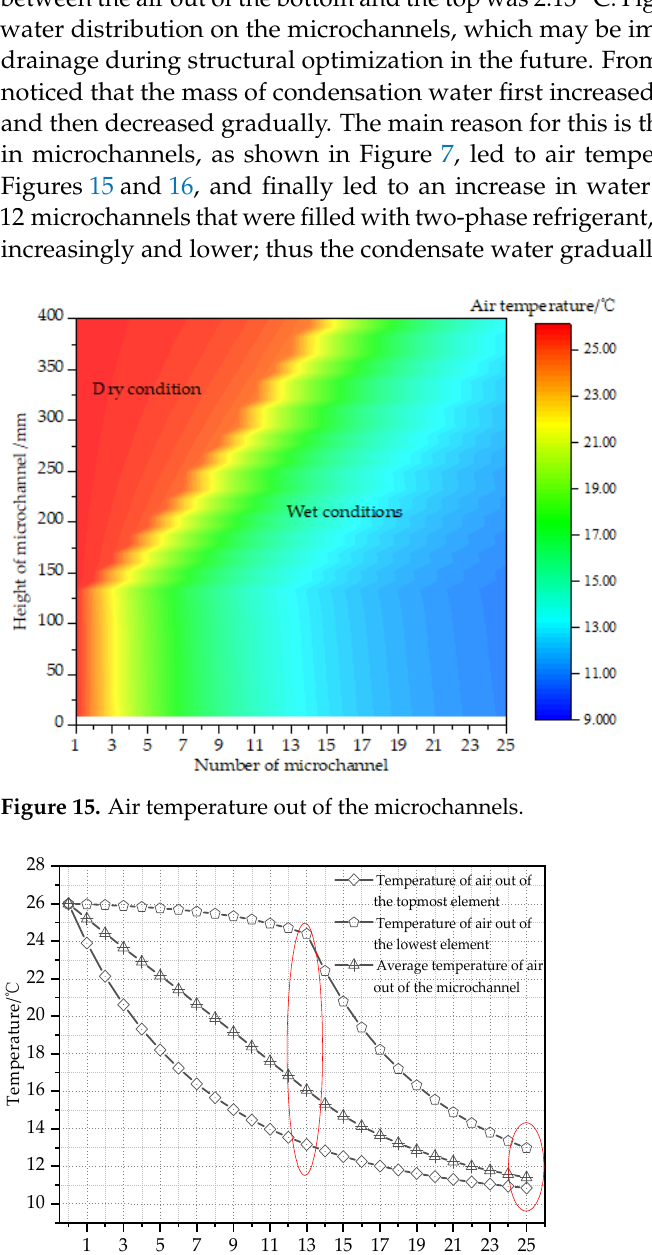
Figure 16. Air temperature change in the airflow direction.